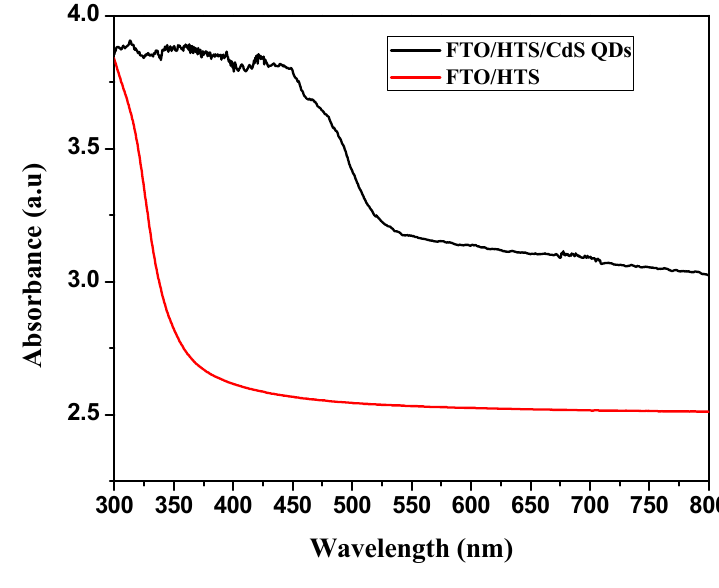
Figure 5. Absorbance spectra of HTS and HTS/CdS